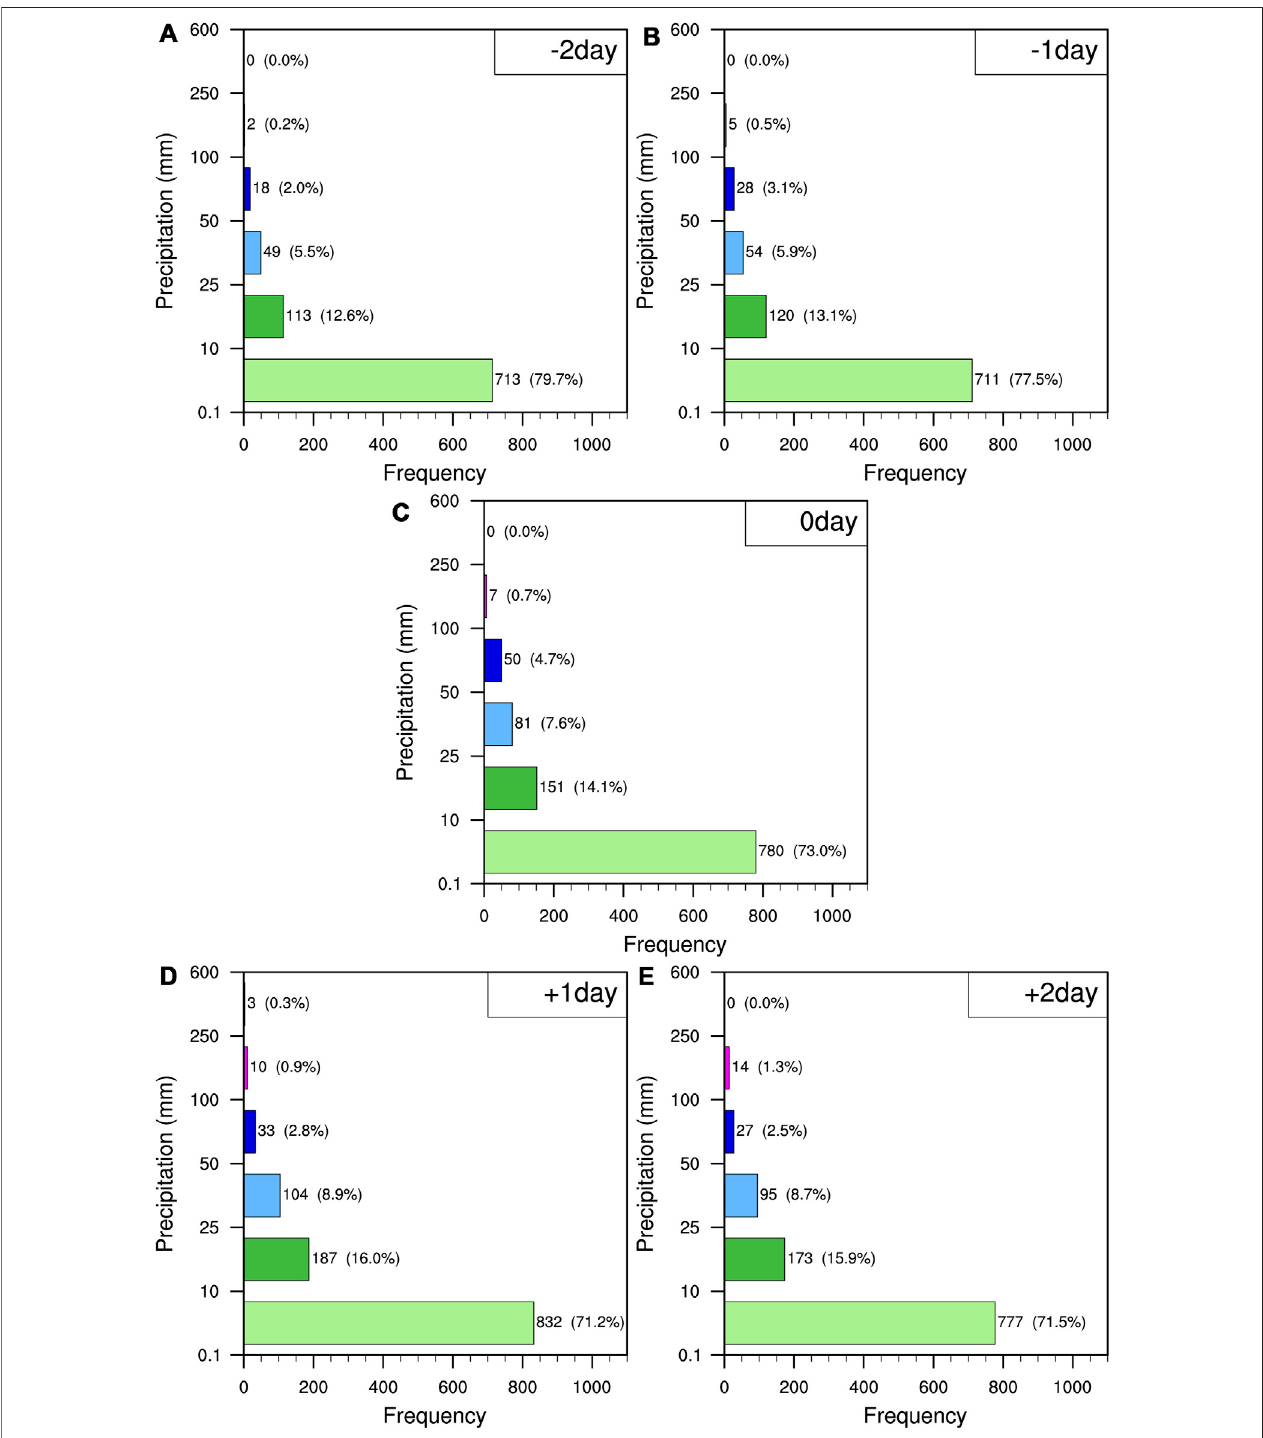
FIGURE 5 | Grade of daily precipitation (units: mm) for seismic area rainfall in the in fl uential period.